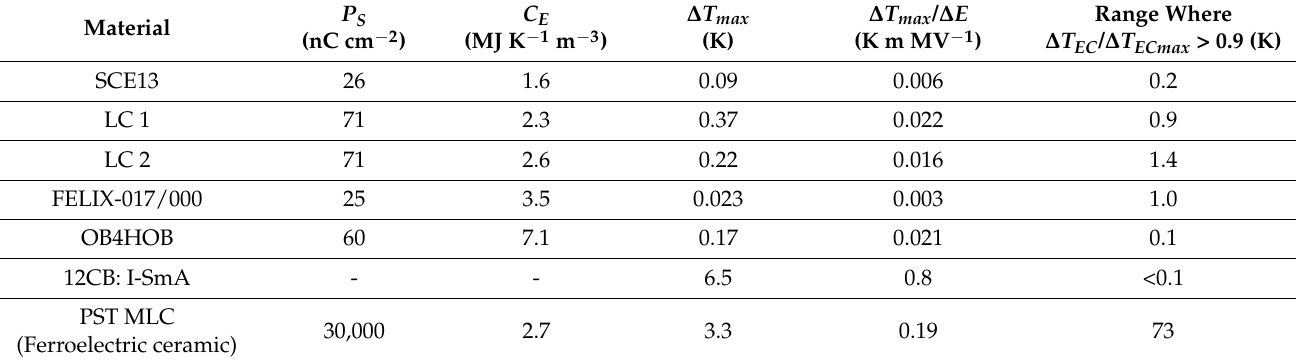
Table 1. The maximum spontaneous polarisation ( P S ), volumetric heat capacity ( C E ), maximum EC temperature change ( T max ), figure of merit, and temperature range over which the electrocaloric tem- perature change remains greater than 90% of the peak temperature change, for the materials studied in this paper and other systems chosen for comparison. The ferroelectric materials FELIX-017/000 and OB4HOB [10] were studied by Bsaibess et al., while Klemenˇciˇc et al. induced a temperature change at the isotropic to SmA phase transition in 12CB [25]. The ferroelectric ceramic, lead scandium tantalate, PST, [39] arranged in a multilayer capacitor MLC is also included. The temperature changes for 12CB and PST are direct measurements, and all other measurements are